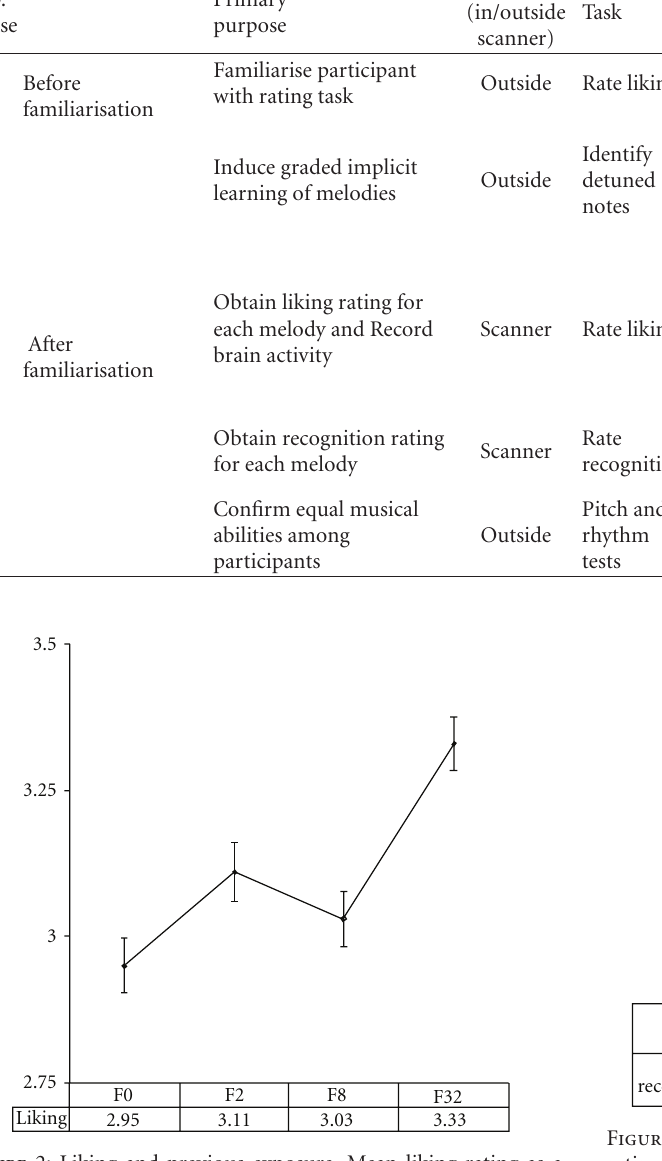
Table 1: Experimental procedure. Overview of the five main phases of the experimental procedure, divided into phases before and after familiarisation with the melodies. For each phase is listed its main purpose, where it took place (in the MRI scanner or not), the central stimuli used, the task of the participant in relation to these stimuli, and a note about which figures and tables relate to each phase. Exp.